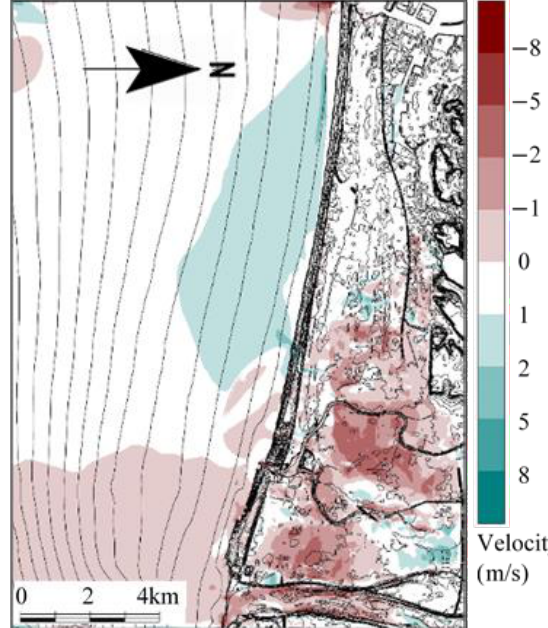
Figure 14. Tsunami velocity 33 min after the start of calculation (present condition).